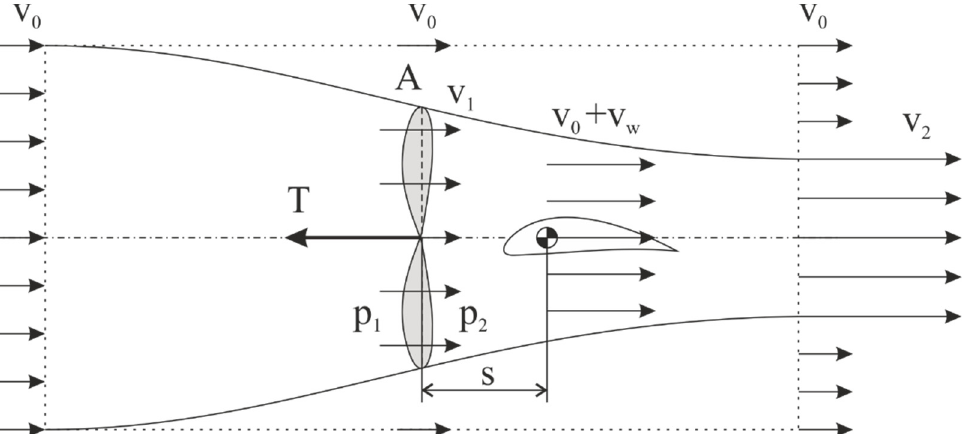
Figure 1. Description of the flow field around the propeller and wing with a description of the freestream airspeed v 0 and propeller-induced velocity on the wing v w The additional velocity on the wing is a function of propeller-induced velocity (cid:1874) (cid:3036) and multiplied by the development factor: